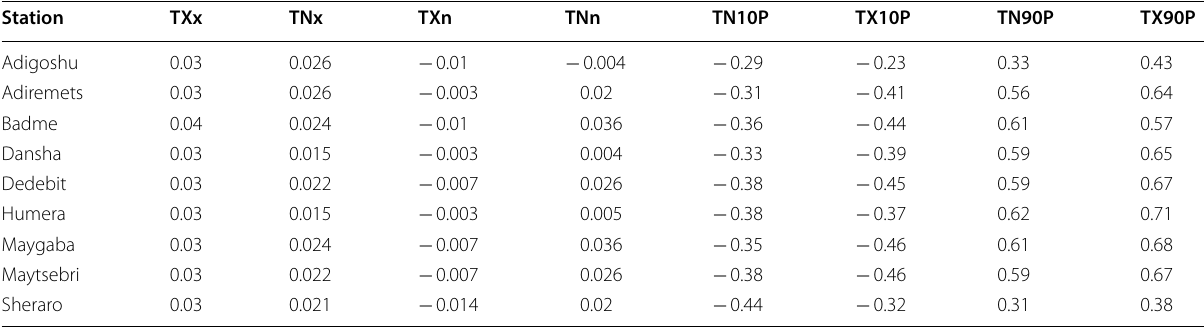
Table 3 Trend analysis on extreme temperature indices from 1983 to 2016 for nine stations Station